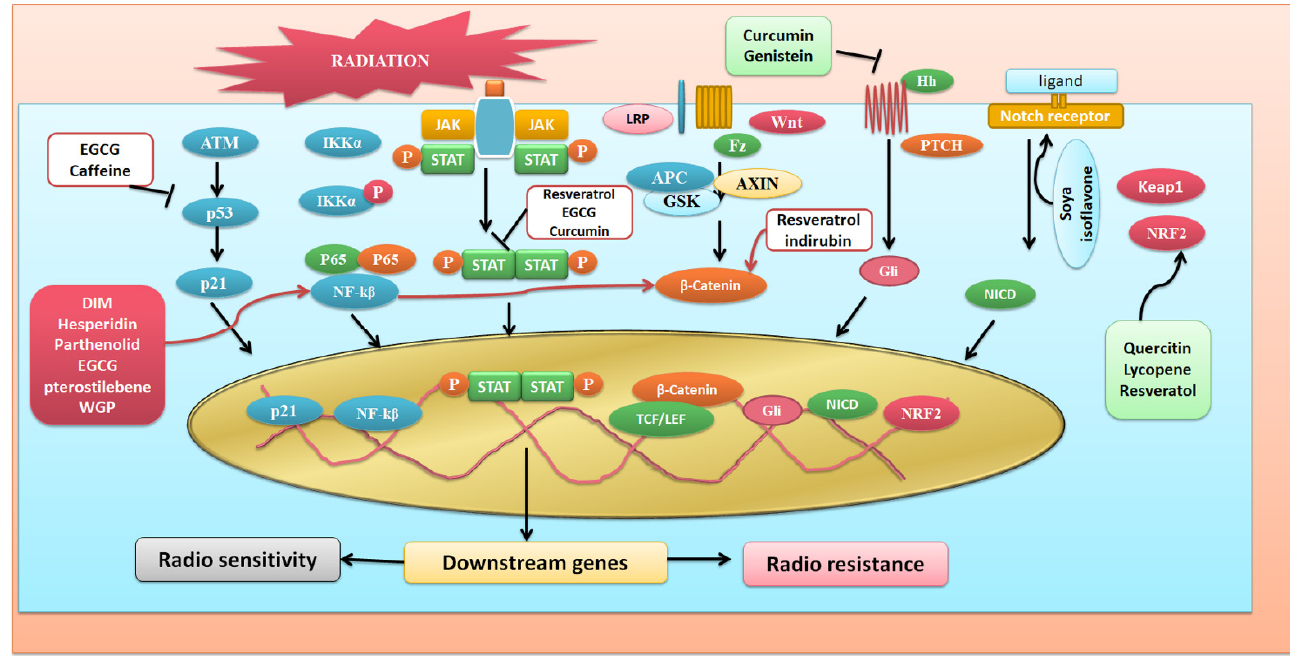
Figure 3. Phytochemicals and their targets on different radiation induced different signaling